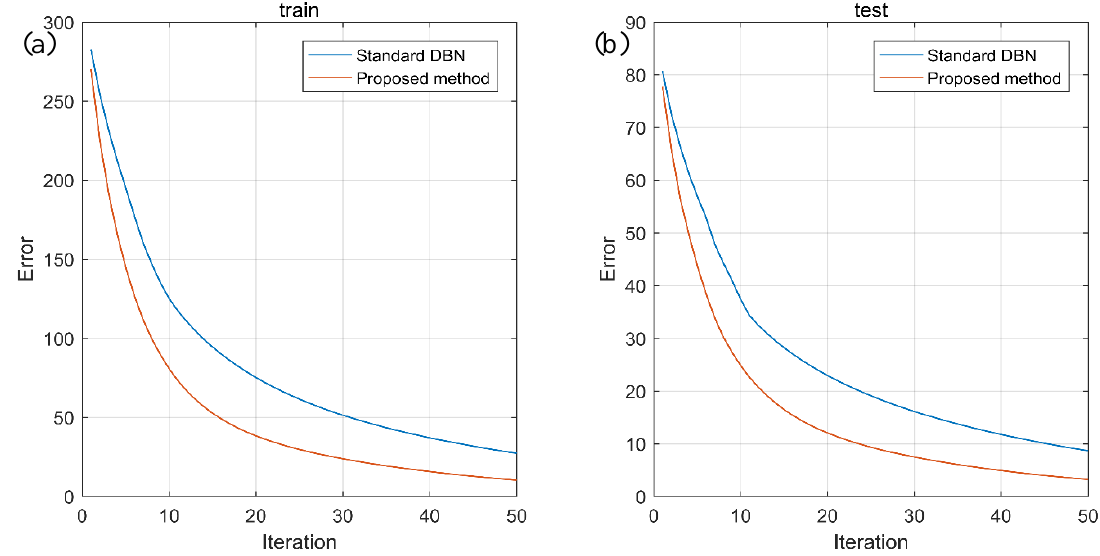
Figure 10. E rrors’ trends of ( a ) training and ( b ) testing models for identifying fault type. Figure 10. Errors’ trends of ( a ) training and ( b ) testing models for identifying fault